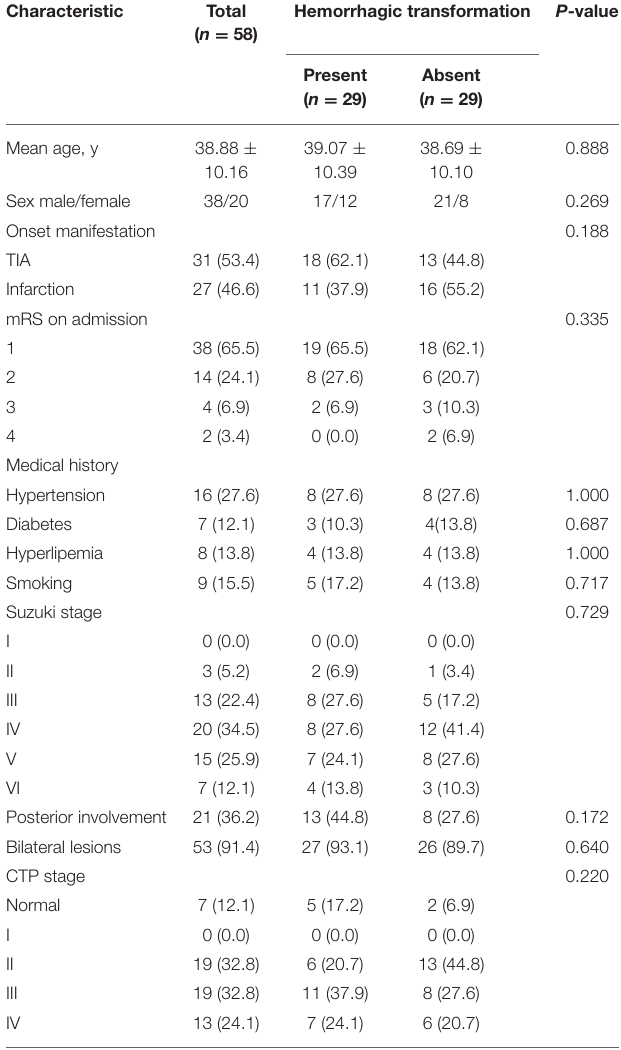
TABLE 3 | Baseline characters of patients in the propensity score–matched cases.